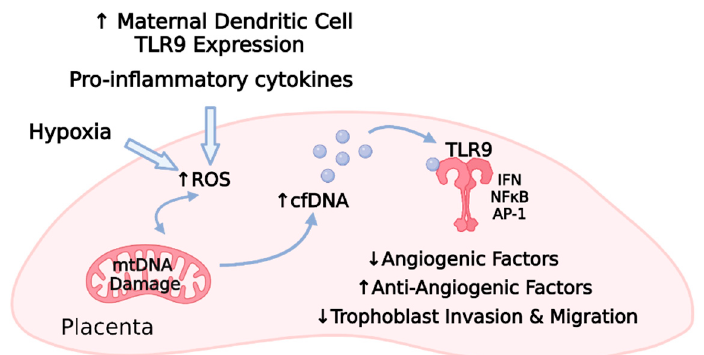
Figure 5. Maternal factors, including TLR9-induced proinflammatory cytokine release and placental hypoxia, promote a cascade of oxidative stress, mitochondrial DNA damage, cell-free DNA release, TLR9 activation, and subsequent TLR9 activation within the placenta [83,244–252,254,255]. Animal and cell culture models indicate that TLR9-related signaling results in decreased angiogenic factors, increased antiangiogenic factors, and impaired trophoblast function [83] (TLR9, toll-like receptor 9; ROS, reactive oxygen species; mtDNA, mitochondrial DNA; cfDNA, cell-free DNA; IFN, interferon; NF κ B, nuclear factor kappa B; AP-1, activator protein-1; ↑ refers to upregulation; ↓ refers to downregulation).